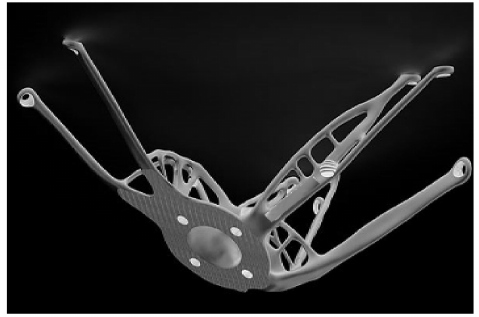
Figure 11. AM made reaction wheel bracket